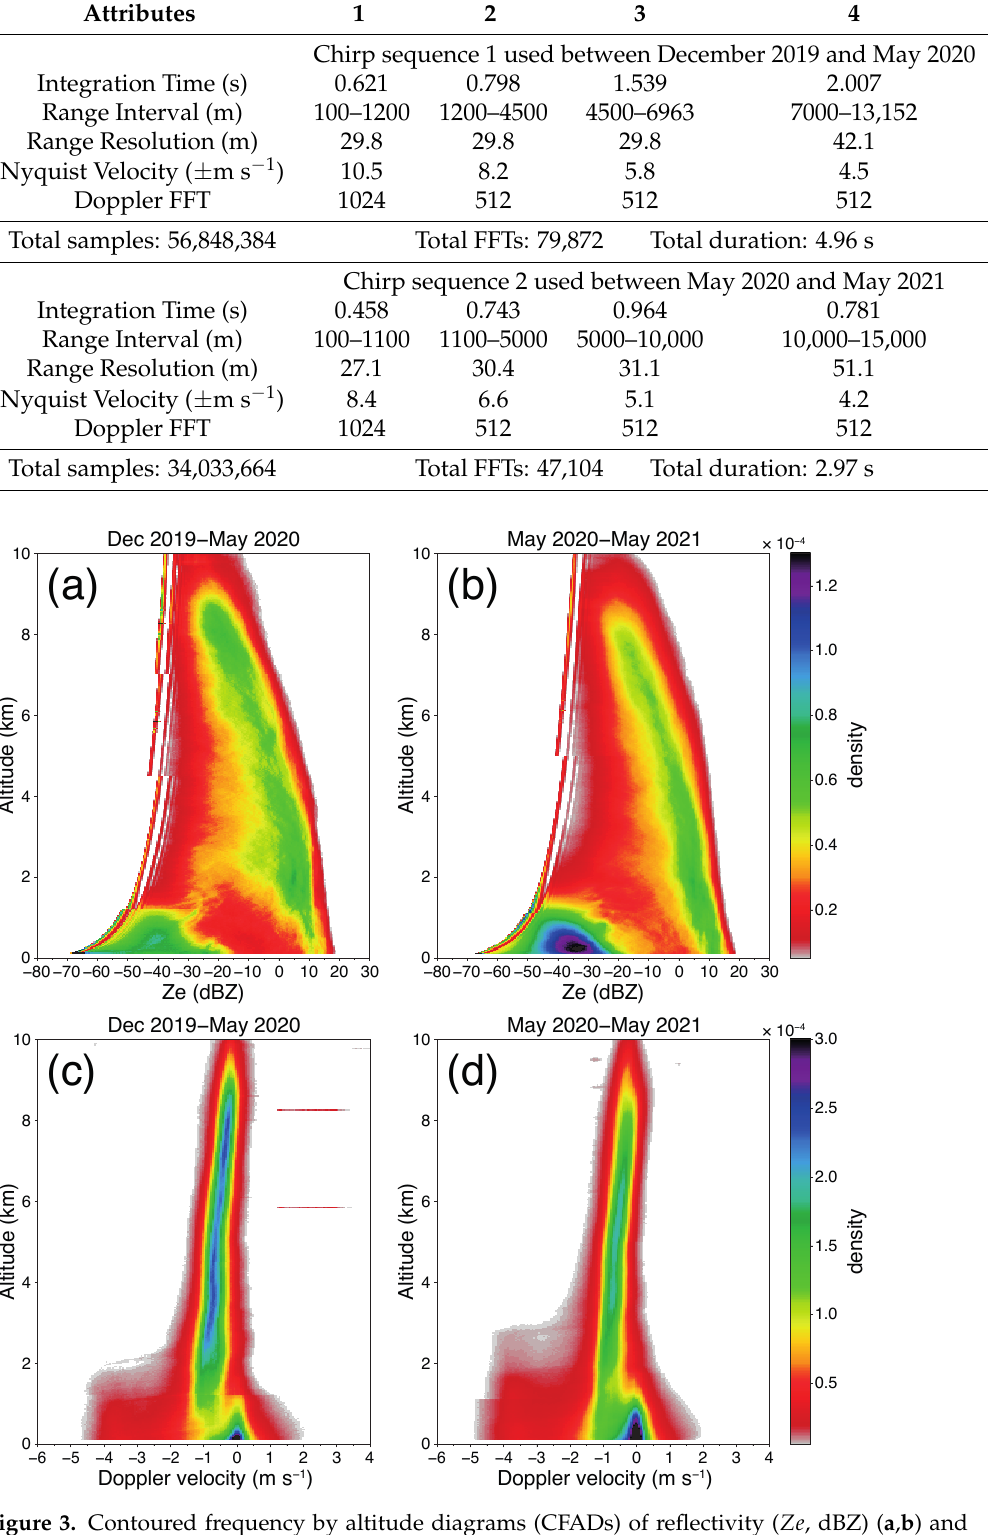
Figure 3. Contoured frequency by altitude diagrams (CFADs) of reflectivity ( Ze , dBZ) ( a , b ) and Doppler velocity ( v , m s − 1 ) ( c , d ) for Dec 2019–May 2020 ( a , c ) and May 2020–May 2021 ( b , d ). These two periods correspond to the two chirp sequences described in Table 2 used during the study period. The probability density as a percentage is shaded according to the